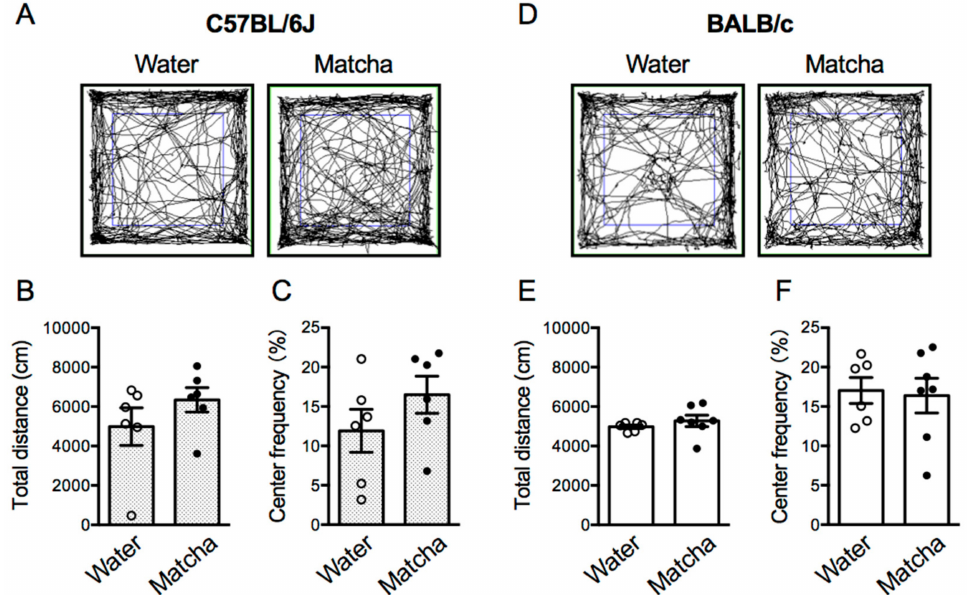
Figure 6. Effects of Matcha tea powder on locomotor activity in the open field test in C57BL/6J and BALB/c mice. ( A , D ) Representative photographs showing the trajectory of the mouse in the open field test for 10 min. The total distance traveled in the open field arena ( B , E ) and the time spent in the center area ( C , F ) were measured. The open field test was performed 30 min after the Matcha tea powder administration (100 mg/kg, p.o.). The results are expressed as the means ± SEM. n = 6–7 animals. The data were analyzed by the unpaired t